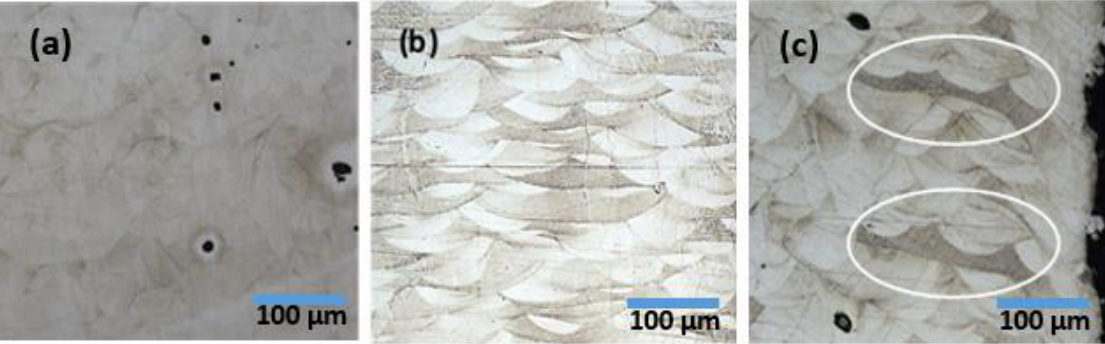
Figure 2. Cross-sectional views of SLM samples on ( a ) x – y plane; ( b ) x – z plane; and ( c ) y – z plane.